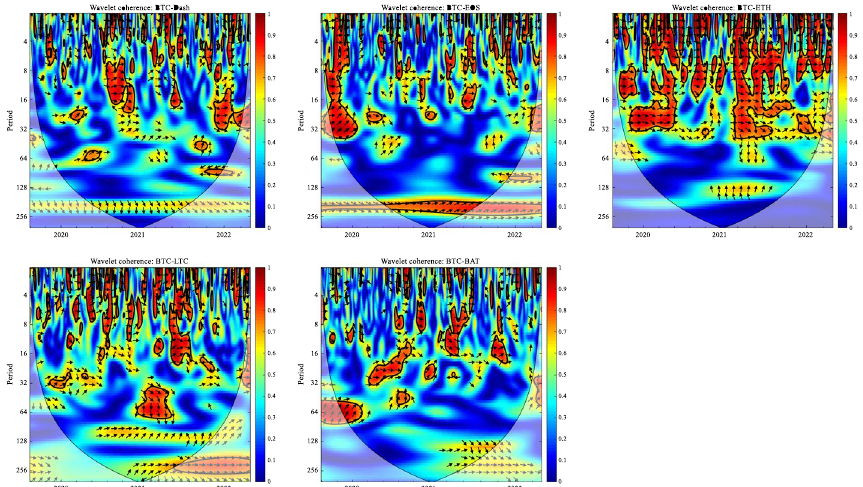
Fig. 4 Wavelet coherence—realized skewness